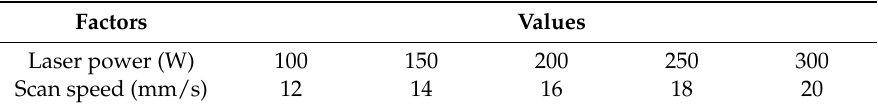
Figure 2 . High Power Diode Laser (HPDL) system. Figure 2. High Power Diode Laser (HPDL) system.